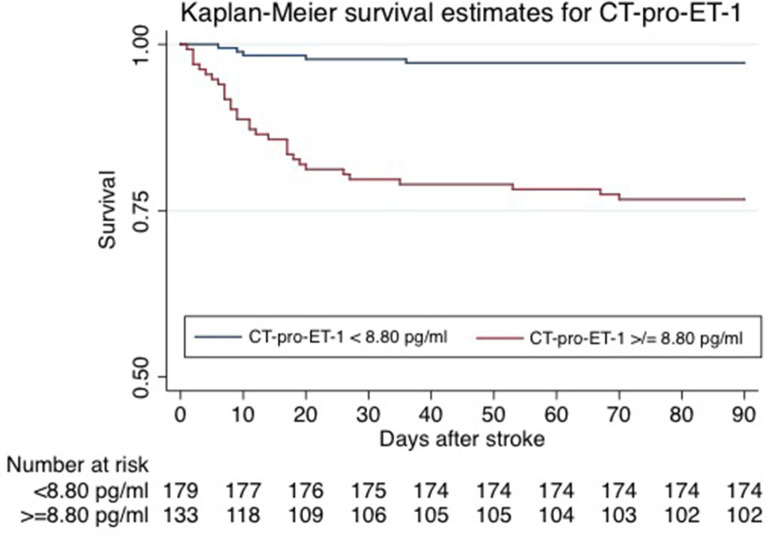
Kaplan-Meier survival estimates of patients stratified by CT-pro-ET-1 on day 1 after admission. Kaplan-Meier survival curves of patients stratified per CT-pro-ET-1 cut-off levels <8.80 and ≥8.80 pg/ml differed significantly (p = <0.001, log-rank test).